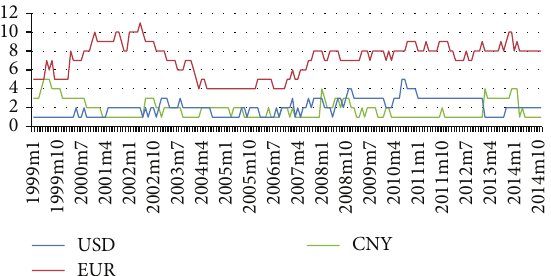
Figure 10: The number of links with respect to USD, EUR, and CNY (window length = 60 months).